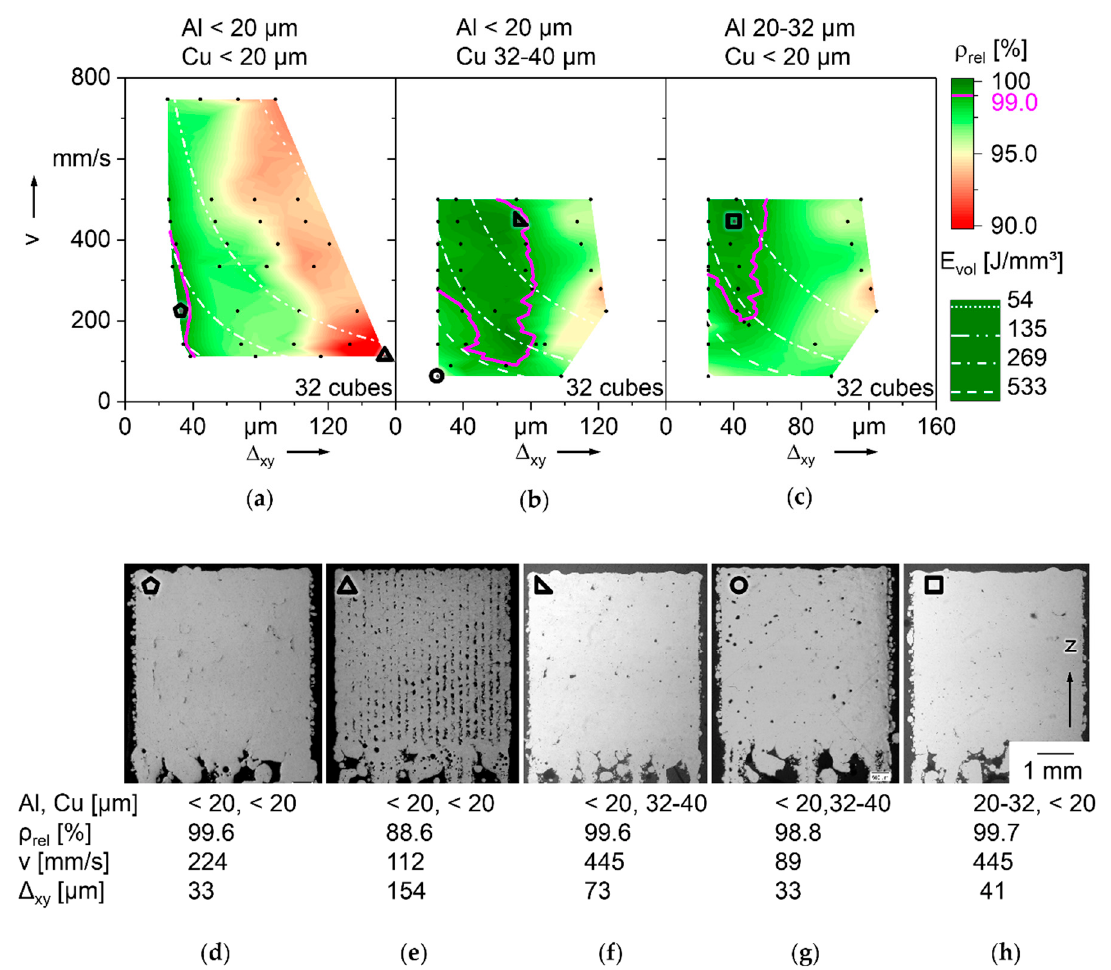
Figure 12. LBM process maps of Al-Cu powder mixtures with three different PSD, constant composition Figure 12 . LBM process maps of Al-Cu powder mixtures with three different PSD, constant 94.7 wt% Al, 5 wt% Cu, and 0.3 wt% SiO x ; ( a – c ) ρ rel over v and ∆ xy , pink contour ρ rel = 99%, E vol isolines composition 94.7 wt% Al, 5 wt% Cu, and 0.3 wt% SiO x ; ( a – c ) ρ rel over v and Δ xy , pink contour ρ rel = in white; ( a ) Al and Cu particles < 20 µ m; ( b ) Al < 20 µ m, Cu 32–40 µ m; ( c ) Al 20–32 µ m, Cu < 20 µ m; 99%, E vol isolines in white; ( a ) Al and Cu particles < 20 µm; ( b ) Al < 20 µm, Cu 32–40 µm; ( c ) Al 20–32 ( d – h ) exemplary micrographs; ( d ) few defects; ( e ) ∆ xy too large; ( f ) few defects; ( g ) many spherical µm, Cu < 20 µm; ( d – h ) exemplary micrographs; ( d ) few defects; ( e ) Δ xy too large; ( f ) few defects; ( g )